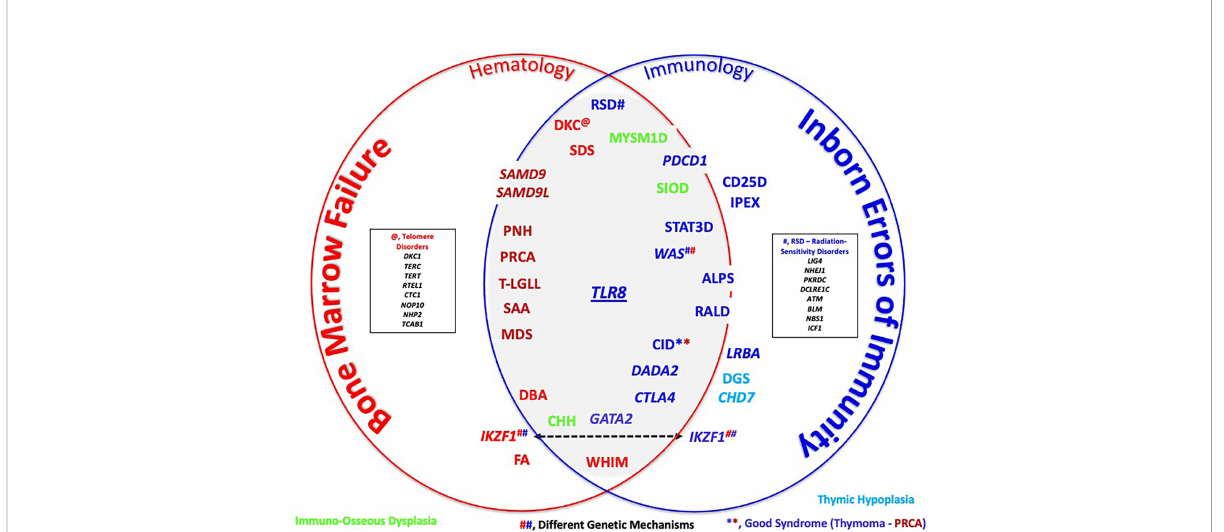
FIGURE 1 Schematic rendering of the bone marrow failure (BMF)/inborn errors of immunity (IEI) interface. Color codes arbitrarily refer to disorders that fi t more with BMF (red) or more with IEI (dark blue). Light blue signi fi es the disorders of thymus development, while green represents immuno- osseous dysplasia disorders. Several genes, such as IKZF1 and WAS , cause disease through different genetic mechanisms (e.g., loss-of-function mutations in WAS cause Wiskott – Aldrich syndrome, while gain-of-function mutations cause X-linked neutropenia). See Table 1 for a detailed listing of disorders that one could fi nd in or near the interface. Terms in italics refer to genes and non-italic to disorders. **, CID on the basis of Good Syndrome. ##, Different Genetic